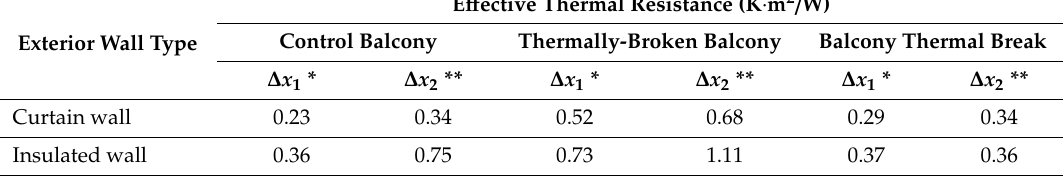
Table 3. Floor slab thermal properties calculated in THERM with two assumed wall types (CM40 thermal break product).